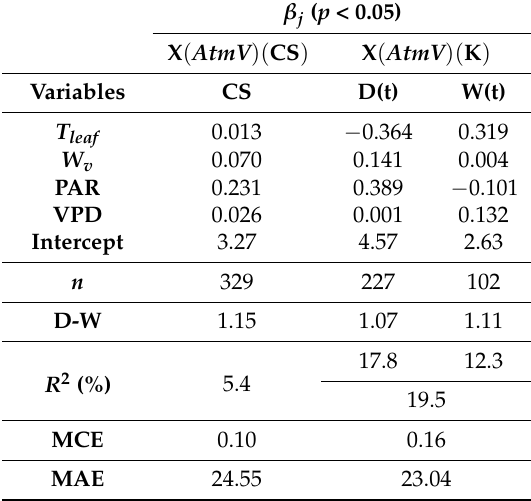
Table 2. Results of the regression for g s as response variable, considering the complete series (CS) and the seasonal adjustment (K) of the atmospheric variables at the canopy level. β j indicates parameter regression; AtmV : atmospheric variables; R 2 , determination coefficient; MCE, modified coefficient of efficiency; MAE, mean absolute error. n corresponds to the sample size used in the analysis (329 records). D ( t ) and W ( t ), analysis corresponding to the dry and wet seasons, respectively. β j ( p <